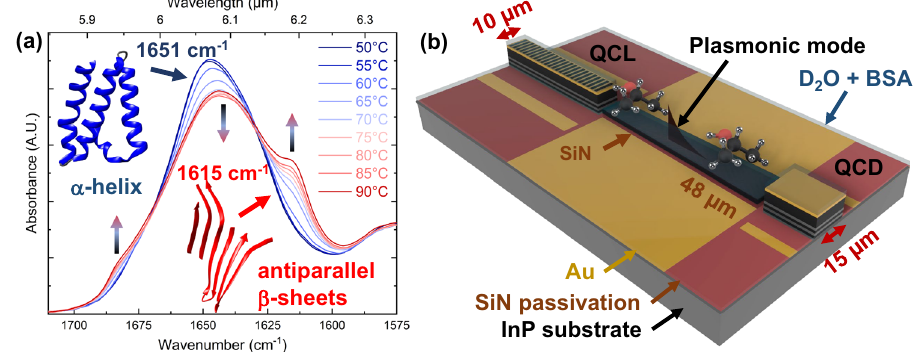
Fig.1|FTIRspectrumofbovineserumalbumin(BSA)&schematicoftheQCLD device. a Attenuated total re fl ection Fourier-transform infrared spectrometer (ATR-FTIR) reference measurement of the thermal denaturation process of BSA, analyzedintherangeoftheamideI 0 bandbetween50 ∘ C(blue)and90 ∘ C(red).The temperature-induced transitionfrom α -helix(1651cm − 1 ,blue)to β -sheet (1615cm − 1 , red) is indicated. b On-chip sensor concept including indicated plasmonic